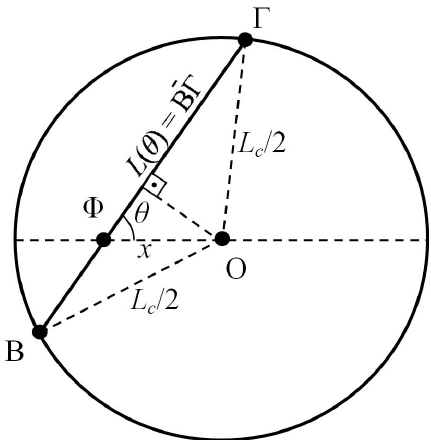
Fig. A1. Schematic illustration of a regularly shaped catchment ap- proximated by a disc with characteristic linear dimension (diameter) L c . The rain gauge is located at point 8